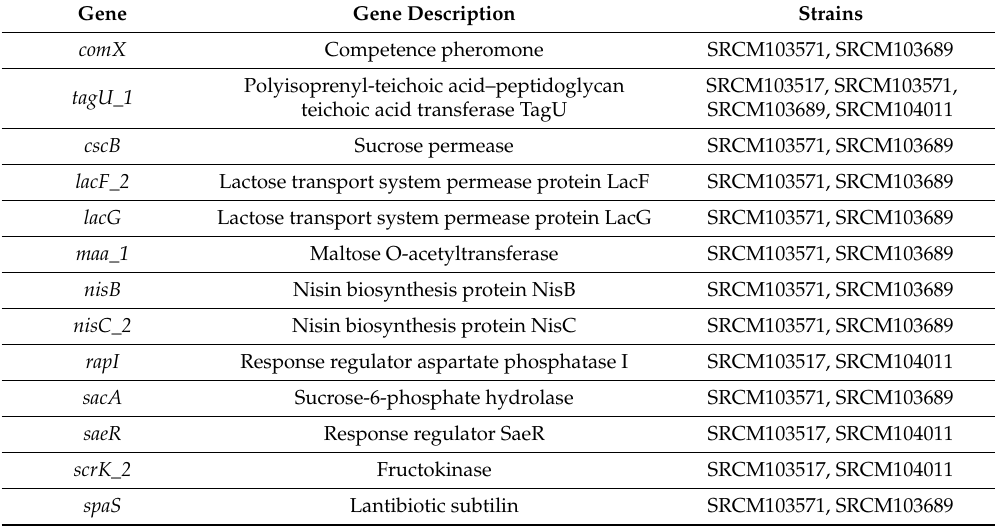
Table 2. Newly isolated B. subtilis -specific genes that are not present in other strains isolated from Korean fermented products.